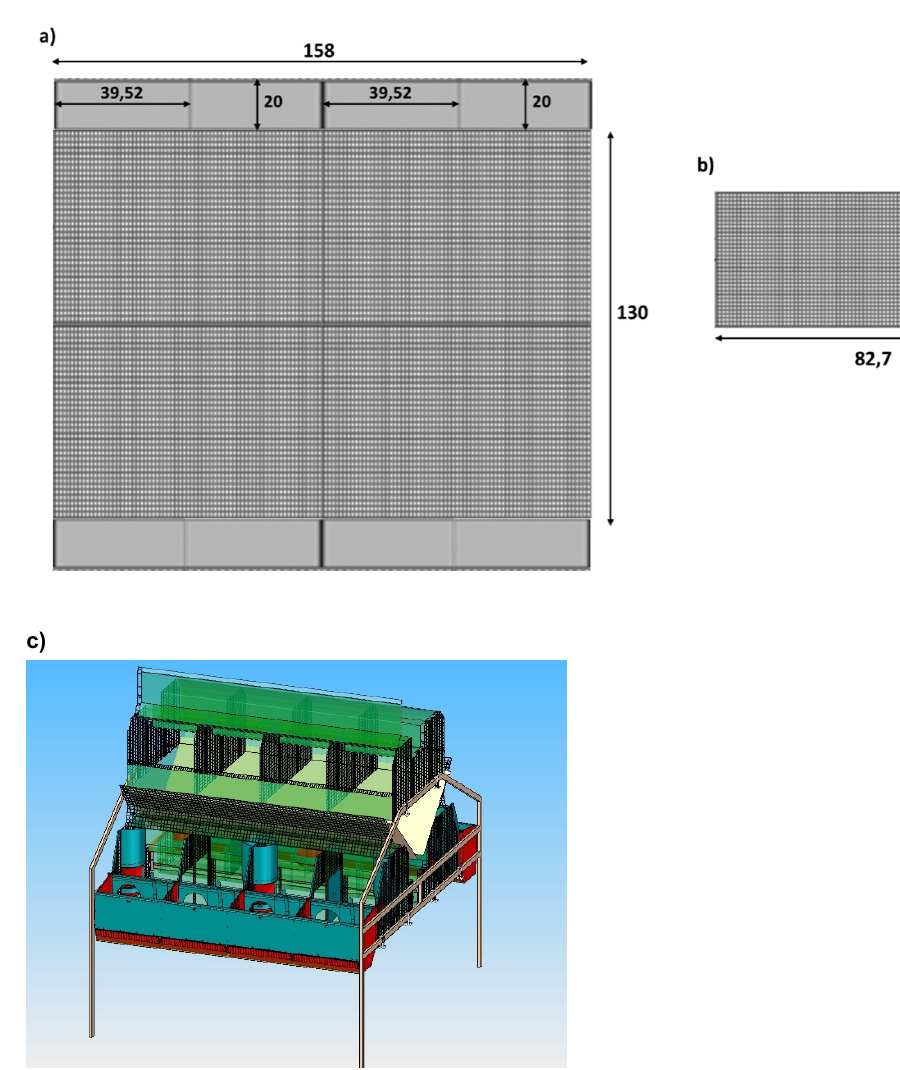
Figure 2. Dimensions (cm) of the combination(C2) colony cage: ( a ) lower level, ( b ) upper level, and ( c ) lateral view with the particulars of removable